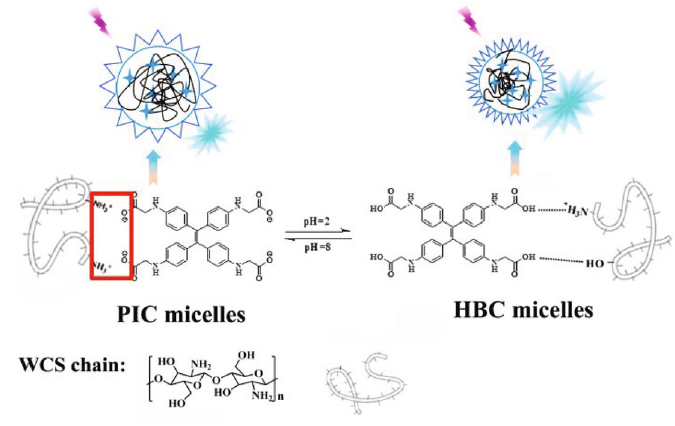
Scheme 1: Schematic illustration of self-assembly between TPE-(N-COOH) micelles, respectively, under acid-based-controlled condition. The pH-mediated transformation of PIC to HBC micelles marked by AIE enhancement is